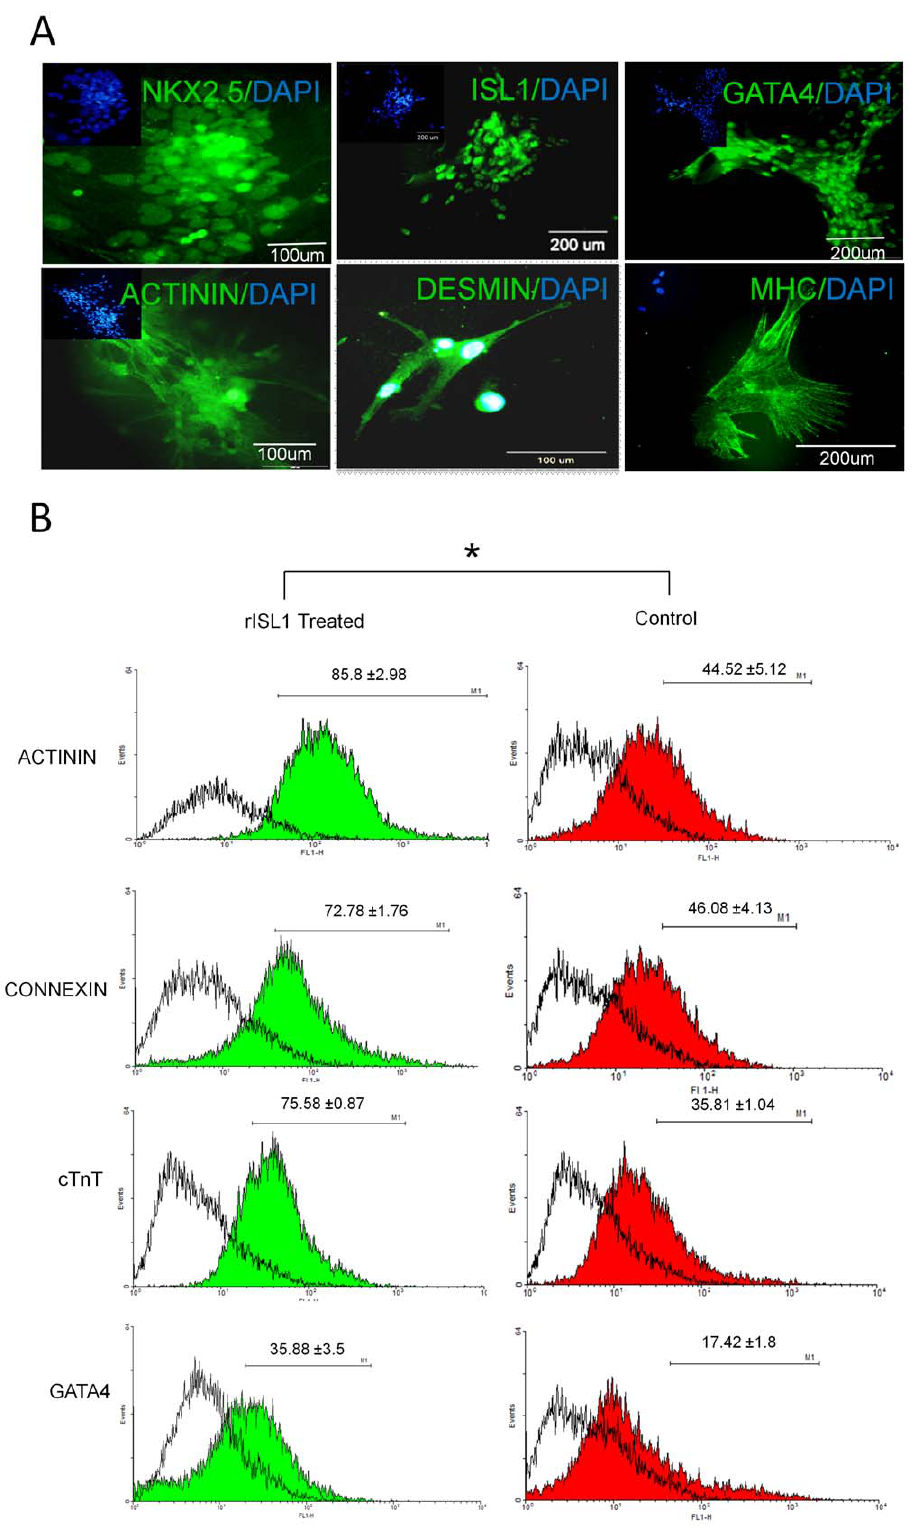
Figure 4. Marker analysis of hESC-derived cardiomyocytes. Cardiomyocytes were dissociated at differentiation day 14 post plating, cultured for an additional 2 days, and assessed by (A) immunofluorescence staining and (B) flow cytometry for cardiac-specific markers. Flow cytometric analysis showed significant increases in the levels of cTnT, CONNEXIN43, ACTININ, and GATA4 protein expression (P , 0.05). ). The experiment was performed for at least 3 independent biological replicates. *: P , 0.05.